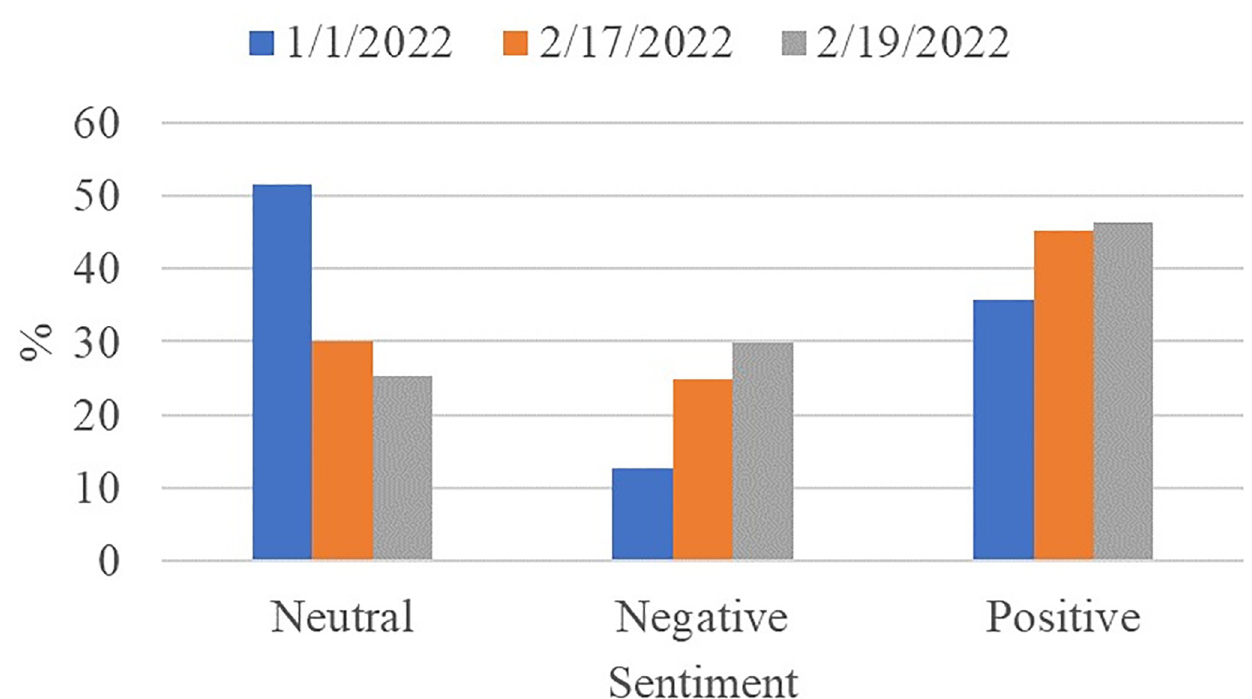
Fig 13. Comparison of positive, negative and neutral tweets on 1st January, 17 February and 19 February 2022.